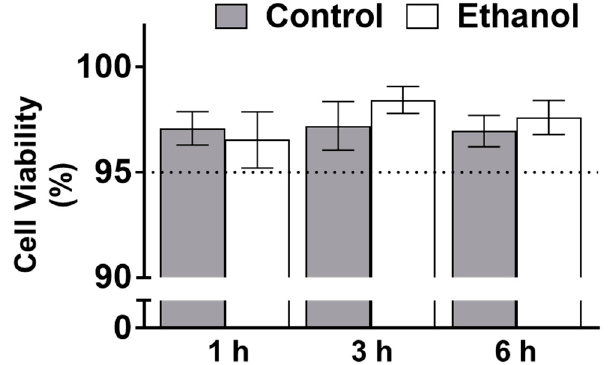
Figure A3. Moderate ethanol does not significantly decrease cell viability in IEC-18 cells using trypan blue exclusion ( n = 4). Cell survival between 95–100% were considered within normal physiological parameters. Error bars represent the SEM and p-values were adjusted for multiple hypotheses using a Bonferroni correction (1 h: p = 2.21, 3 h: 1.16, 6 h: 1.73).